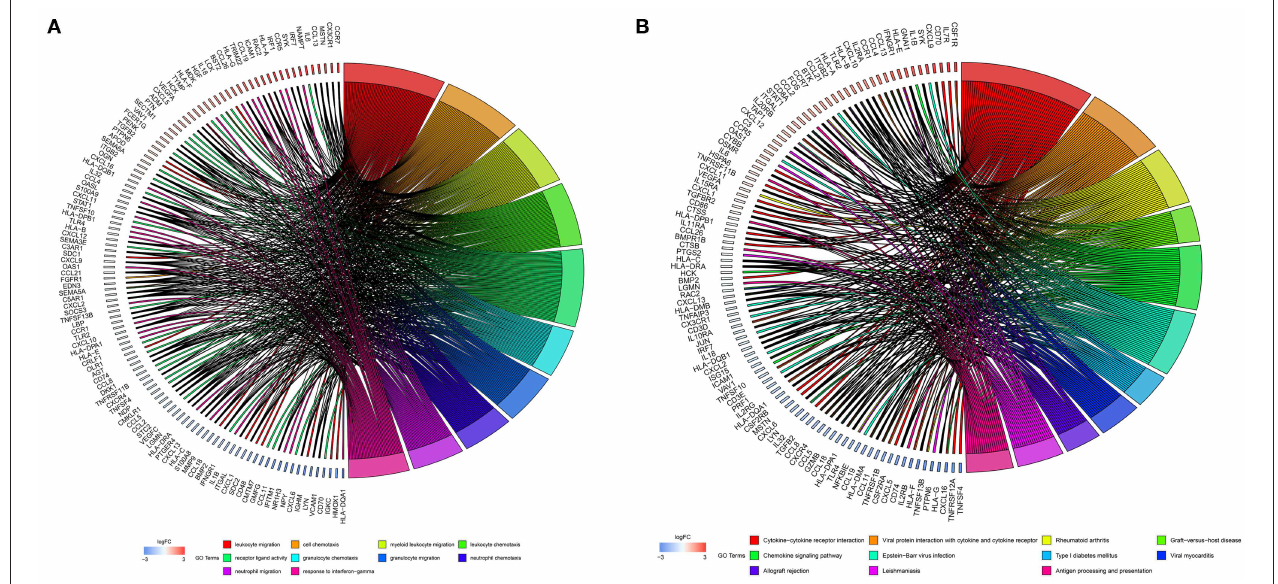
FIGURE 2 | Function enrichment analyses for the overlapped genes from the WGCNA and the Immunology Database and Analysis Portal (ImmPort) database. (A) Gene Ontology (GO) analysis for the immune genes. (B) The Kyoto Encyclopedia of Genes and Genomes (KEGG) pathways for immune